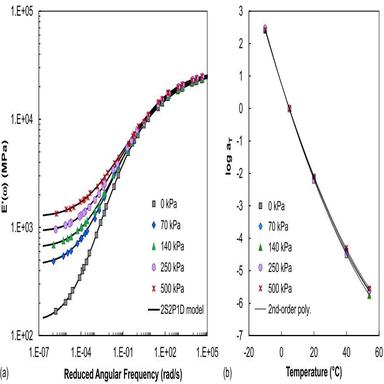
Individual application of the 2S2P1D model at different confining pressures (Mix A): (a) storage modulus master curves, and (b) time-temperature shift factors.